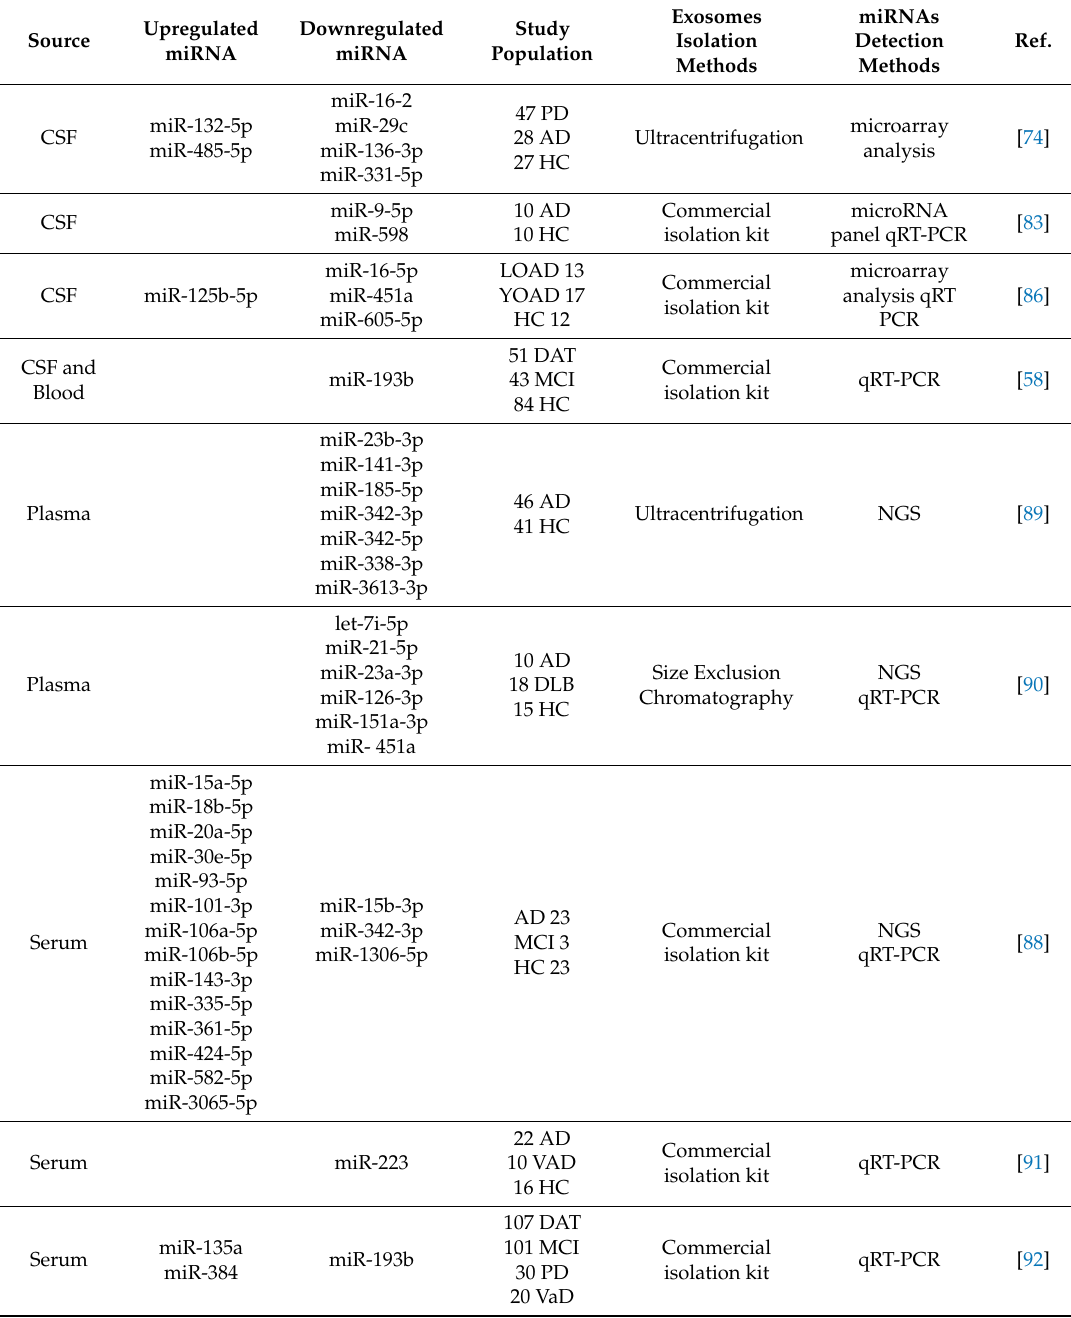
Table 1. Potential exosomal miRNAs biomarkers for Alzheimer’s disease clinical